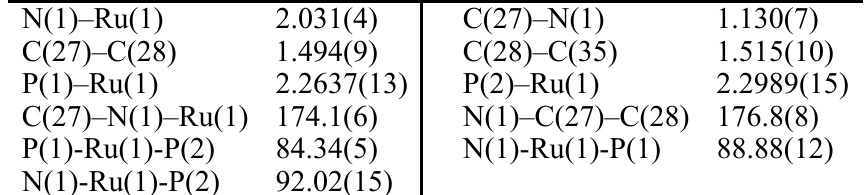
Table 2. Selected bond lengths [Å] and angles [deg] for complex 3a